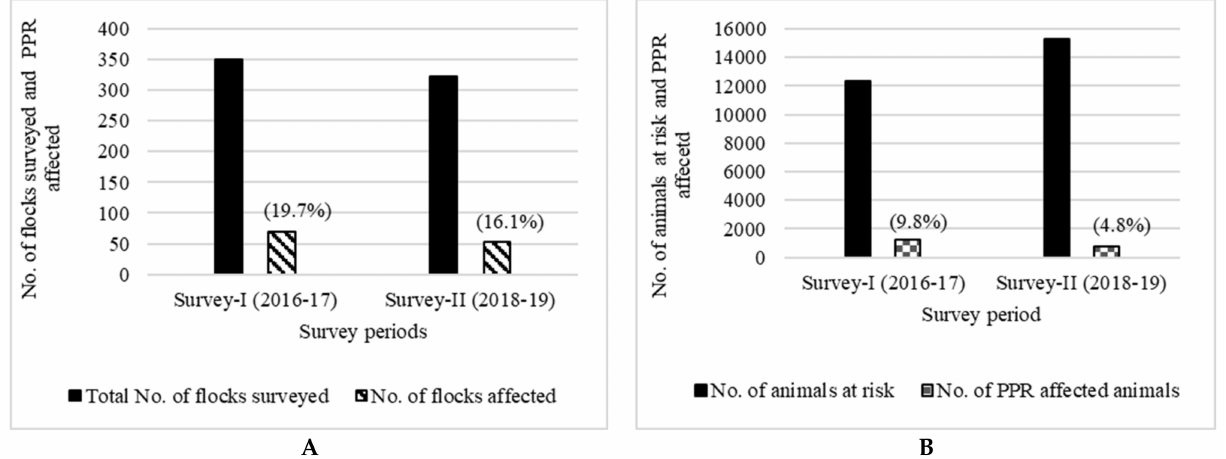
Figure 3. Number of flocks surveyed and proportion of flocks infected with PPR ( A ) and animals at risk and animals infected with PPR ( B ) in survey I and survey II in